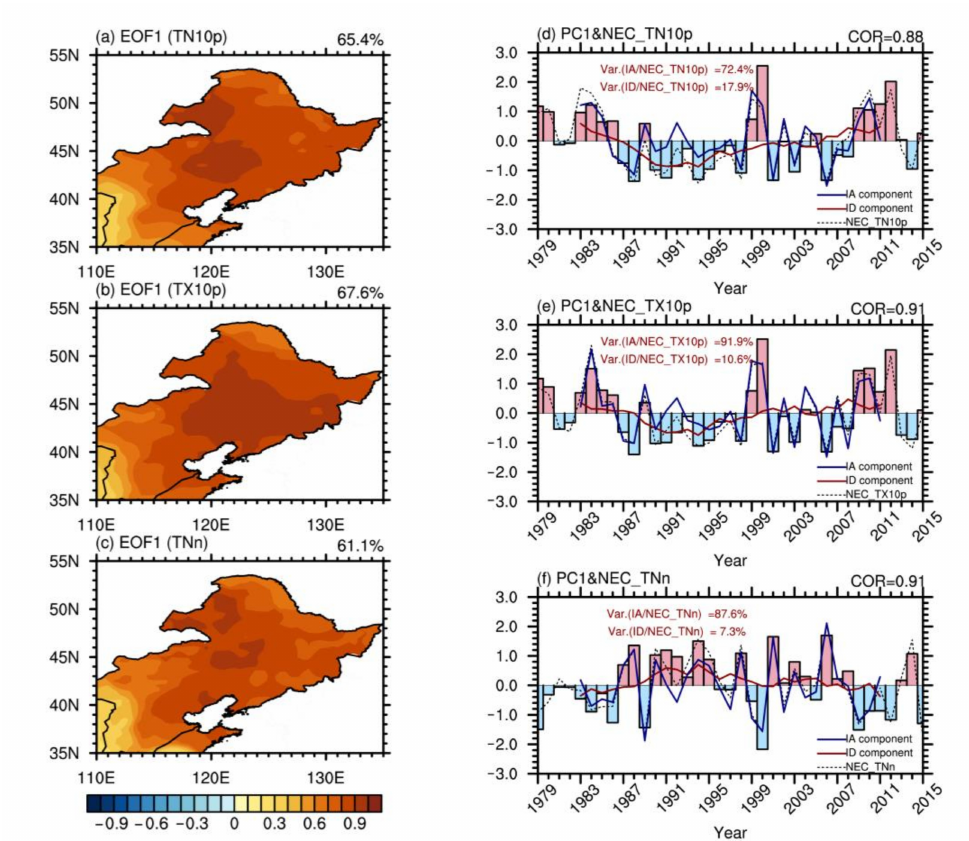
Figure 3. First mode of EOF for ( a ) TN10p (unit: days), ( b ) TX10p (unit: days), and ( c ) TNn (unit: ◦ C) in NEC winters of 1979/80–2015/16, respectively. ( d – f ) Same as ( a – c ), but for PC1 (bar). Standardized time series of regional-mean ( d ) TN10p, ( e ) TX10p and ( f ) TNn in NEC (black dotted line) as well as its interdecadal component (the 9–year moving average, red solid line) and the interannual component (blue solid line) from 1979 to 2015.